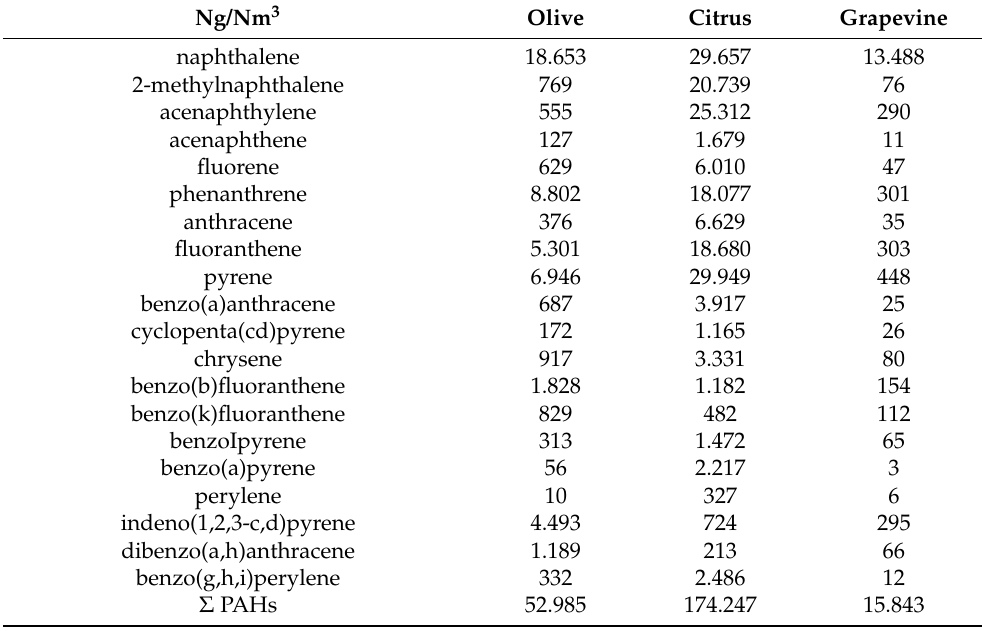
Table 6. PAHs emission concentrations (ng/Nm 3 ) of Olive, Citrus and Grapevine